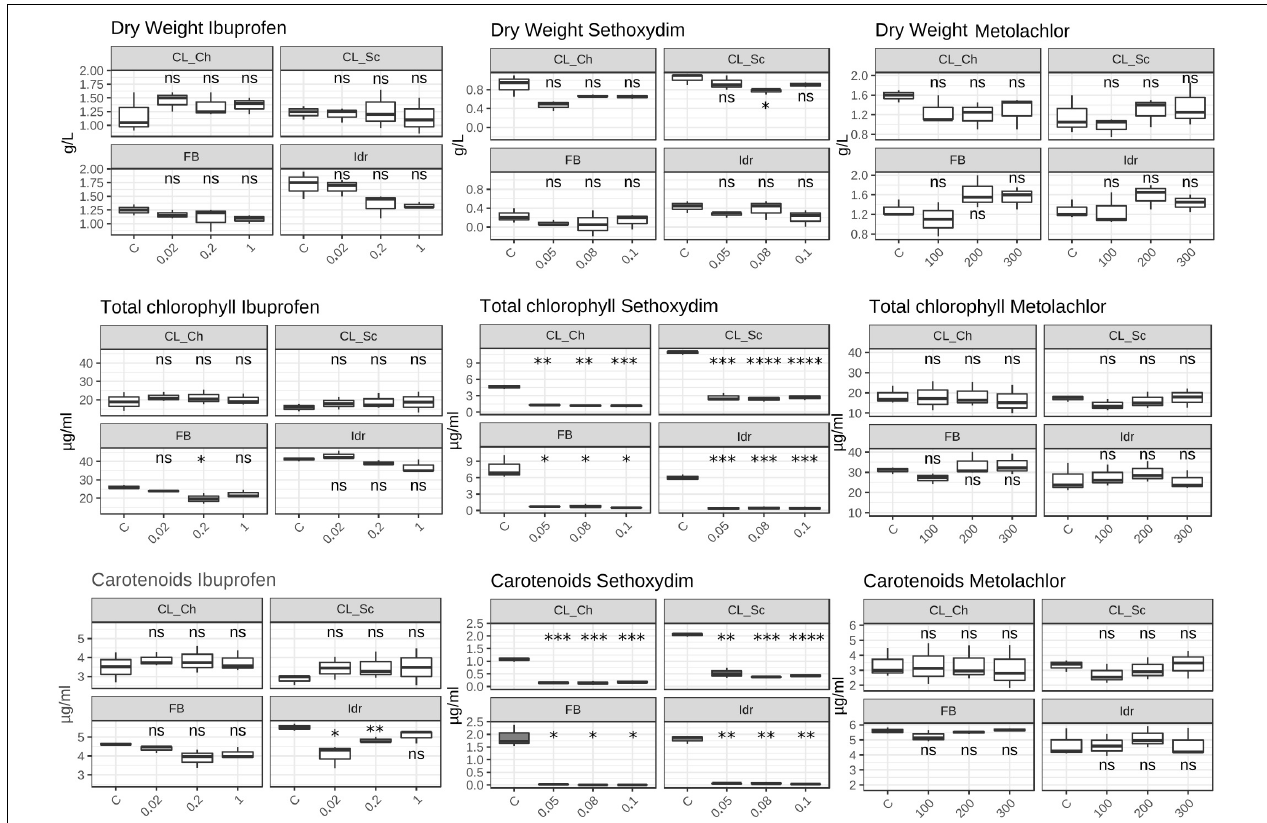
FIGURE 7 | Photosynthetic pigment content and dry weight values measured in herbicides and Ibuprofen tests after 1 week exposure. Upper line: dry weight (mg l − 1 ); middle line: total chlorophyll content ( µ g ml − 1 ); lower line: total carotenoids content ( µ g ml − 1 ). T -test has been applied to compare the effect of the presence of the substances with the control (C). The following convention for symbols indicating statistical significance were used: ns: p > 0.05; ∗ : p ≤ 0.05; ∗∗ : p ≤ 0.01; ∗∗∗ : p ≤ 0.001; ∗∗∗∗ : p ≤